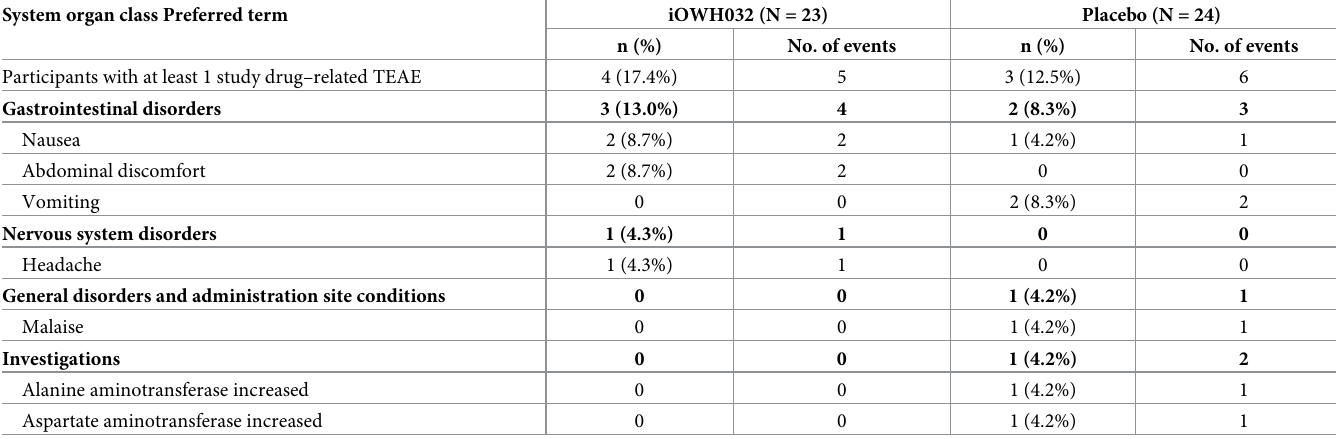
Table 3. Study drug–related treatment-emergent adverse events by system organ class and preferred term in the safety